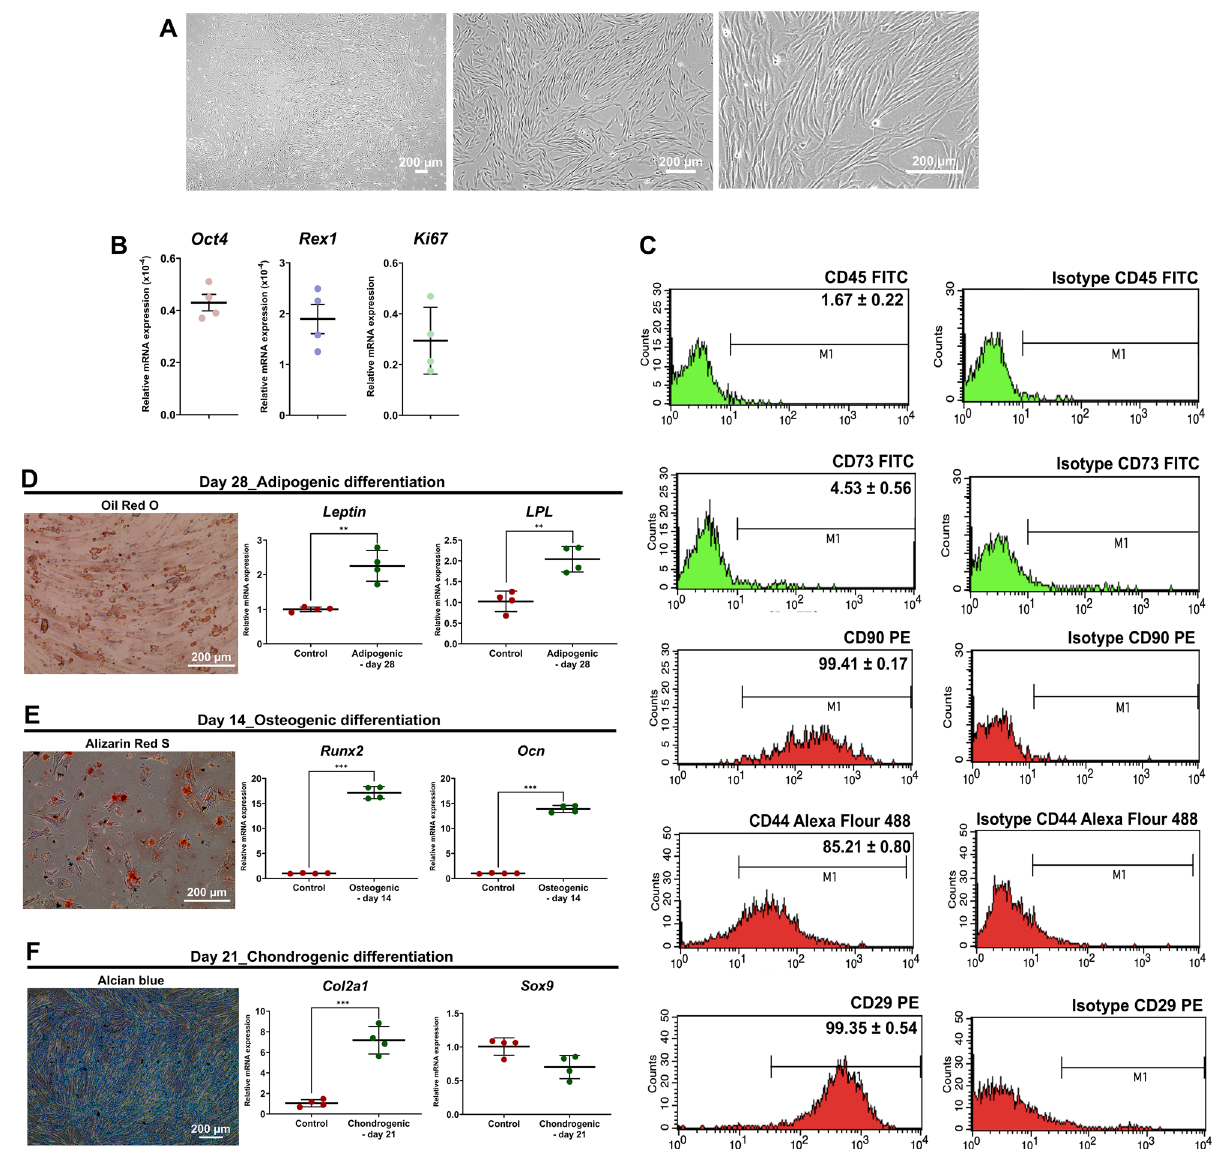
Figure 1. cAD-MSC characteristics. Morphological appearances of cAD-MSCs were observed under a light microscope with magnification of 4X, 20X, and 40X ( A ). The mRNA expression of stemness markers ( Oct4 , and Rex1 ) and a proliferation marker ( Ki67 ) were analyzed by RT-qPCR ( B ), normalized with the reference gene ( Gapdh ). Expression of surface markers exhibiting MSC property were revealed using flow cytometry ( C ). Adipogenic differentiation potential at day 28 post-induction was stained with Oil Red O, and adipogenic related-mRNA expression was determined ( D ). Osteogenesis was confirmed using Alizarin Red S staining at day 14 post-induction, and the expression of osteogenic mRNA markers were assessed ( E ). Chondrogenic differentiation potential at day 21 post-induction was demonstrated by Alcian blue staining, and chondrogenic mRNA markers were determined ( F ). The expression of mRNA genes related to multilineage differentiation was normalized with the reference gene and the undifferentiation control. Bars indicates the significant differences (**, p value <0.01, ***, p value